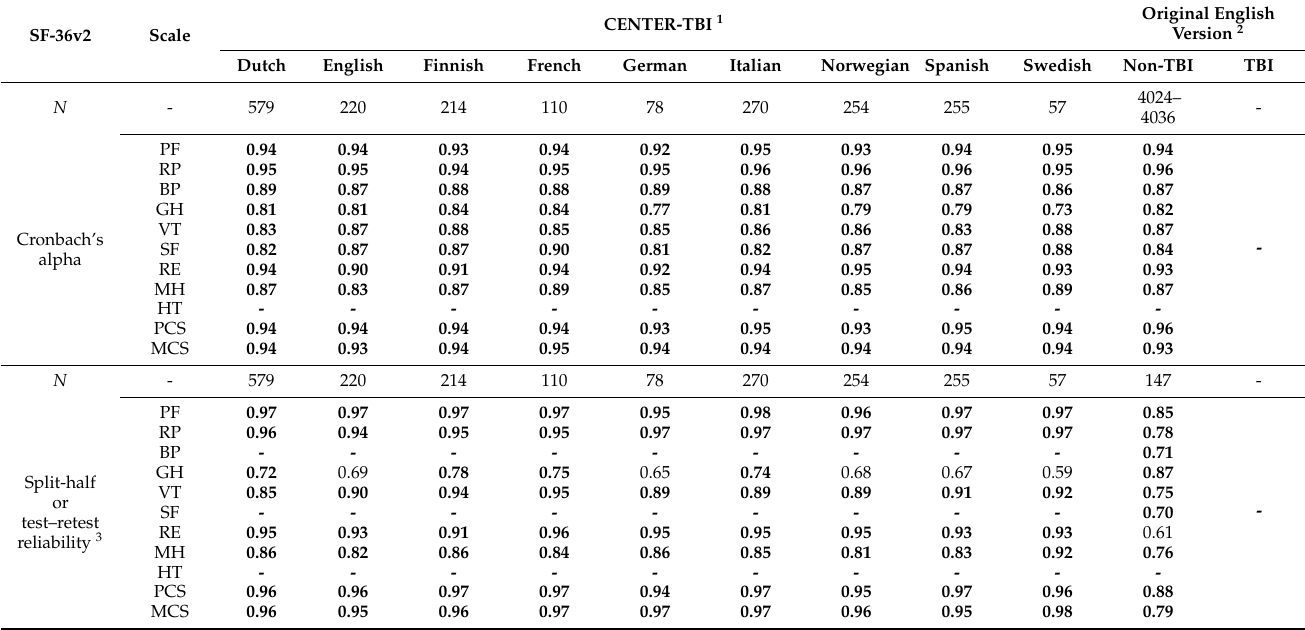
Table 7. Reliability of the SF-36v2: Comparison of the CENTER-TBI results with the values from the original English validation